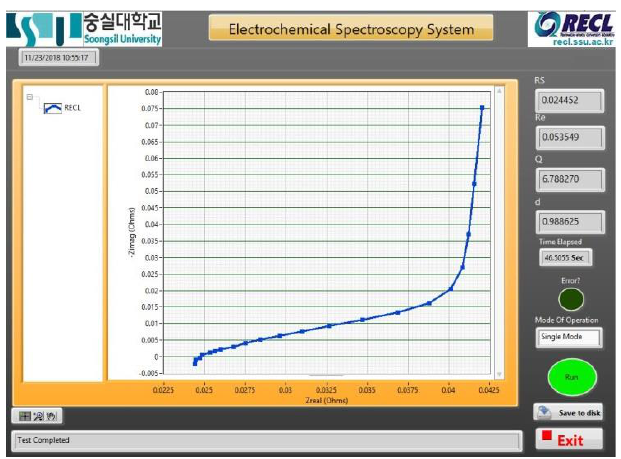
Figure 12. Front panel of developed graphical user interface (GUI).